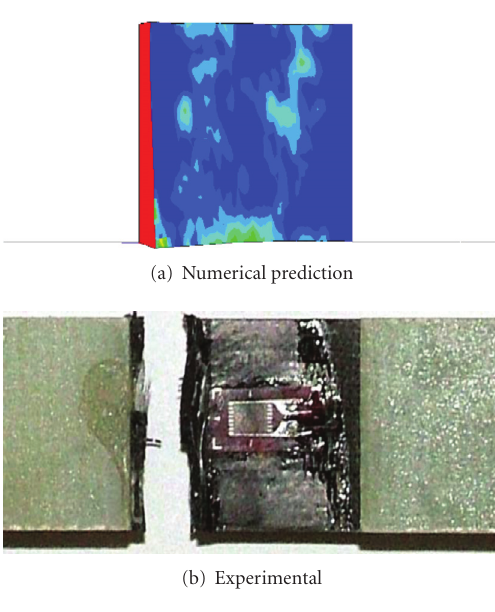
Figure 24: Comparison between predicted and experimental failure locations for the compression test in the fibre